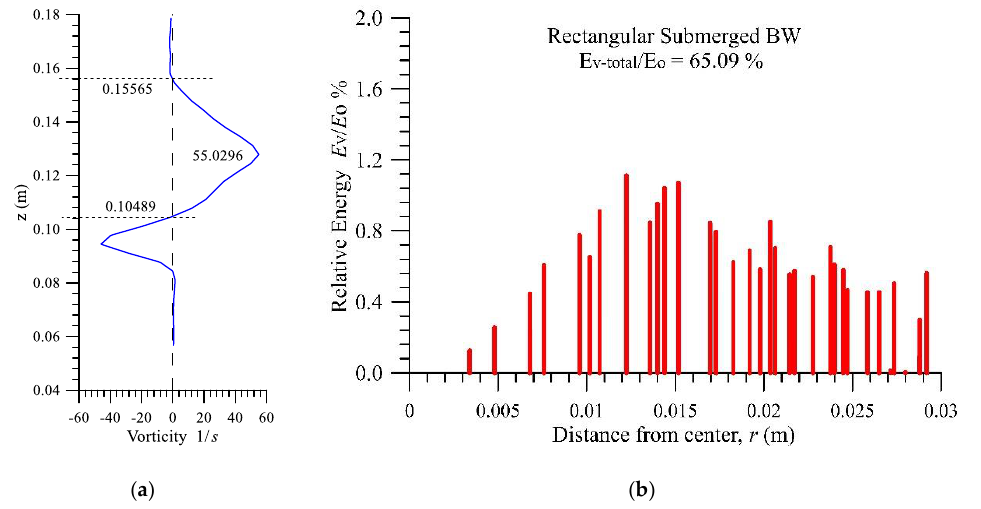
Figure 8. The vorticity and relative energy of the maximum vortex induced by a solitary-like wave propagating over a set of rectangular submerged breakwaters: ( a ) the vorticity distribution along the vertical line of the vortex center; ( b ) the relative vortex energy distribution.